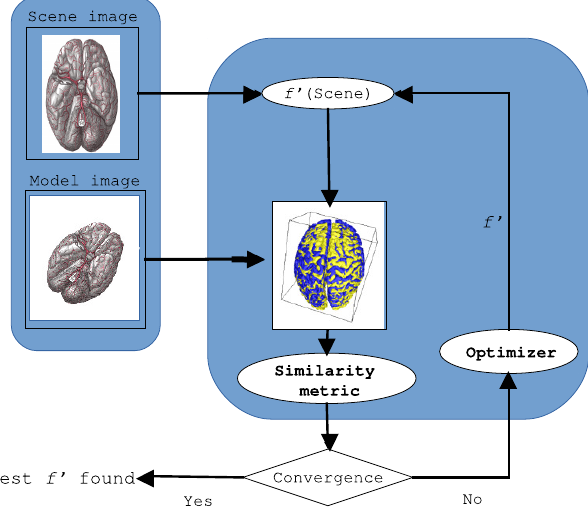
Figure 1. The flow-diagram of the image registration (IR) optimization